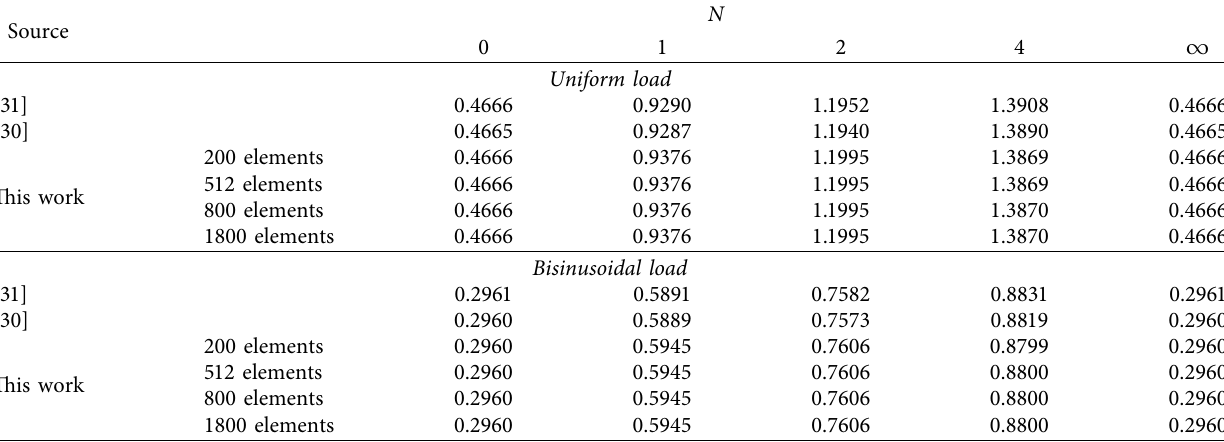
Table 1: Nondimensional displacement 􏽢 w � ( 10 E tributed load and sinusoidal distributed load.